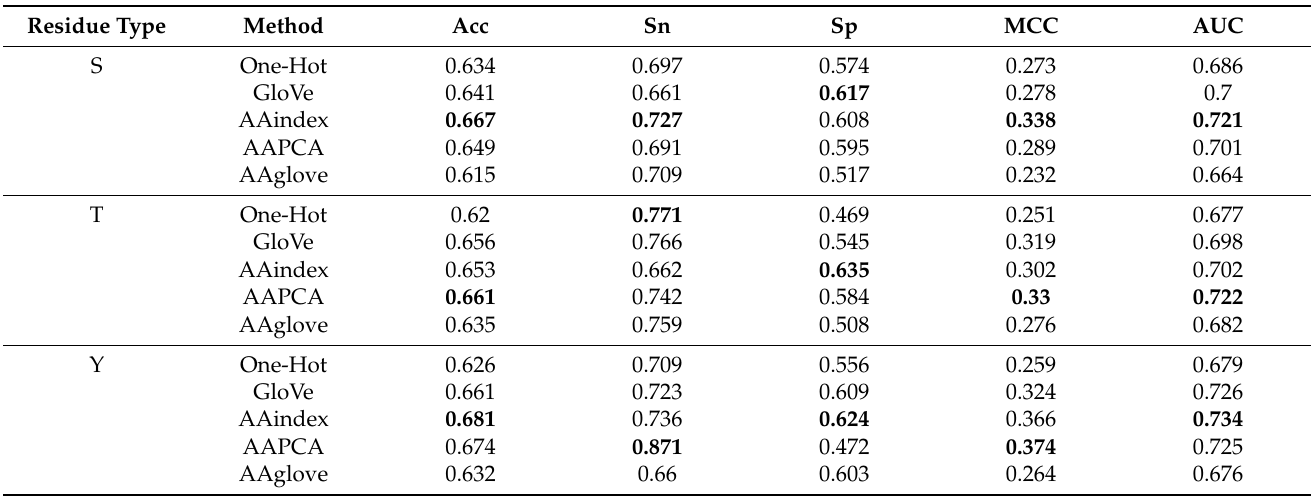
Table 1. Prediction performance of different protein sequence coding methods by the 5-fold cross-